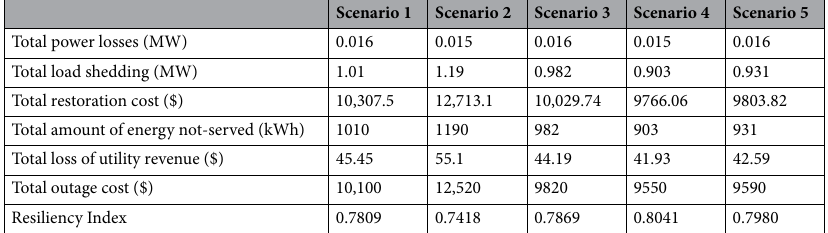
Table 2. Summary of the objectives and resiliency metrics for the five scenarios without EDRP.